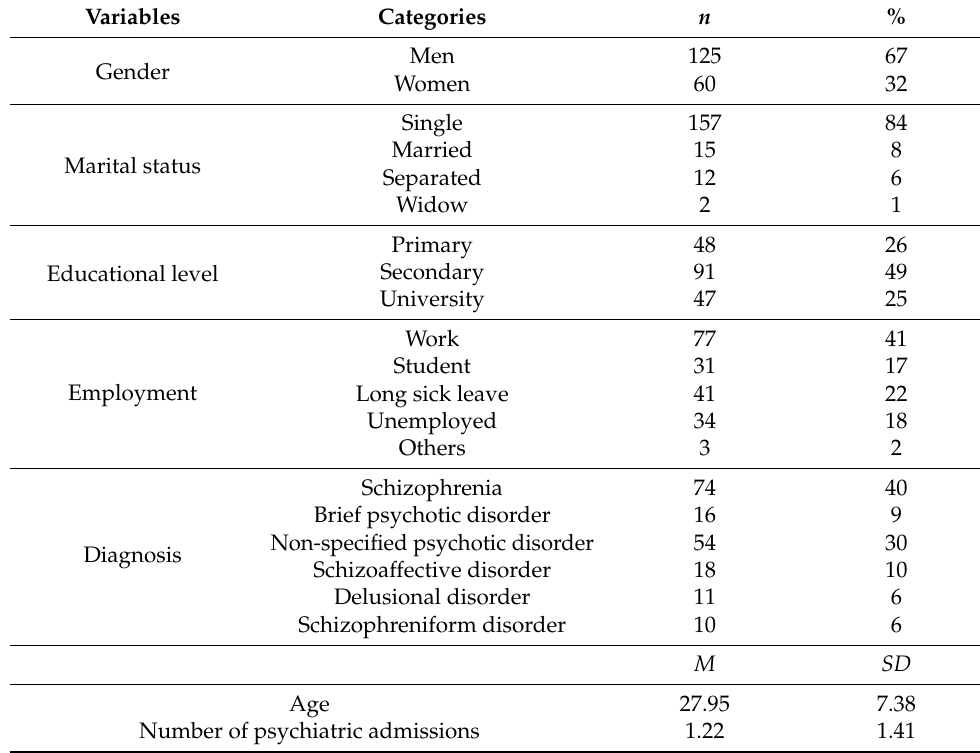
Table 1. Sociodemographic characteristics of the sample.